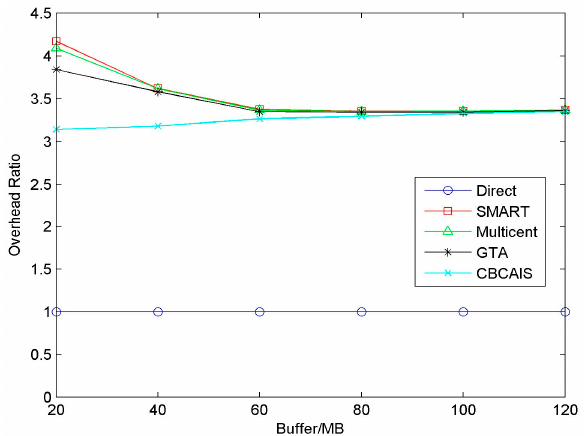
Figure 11. Overhead ratio for varying buffer size.